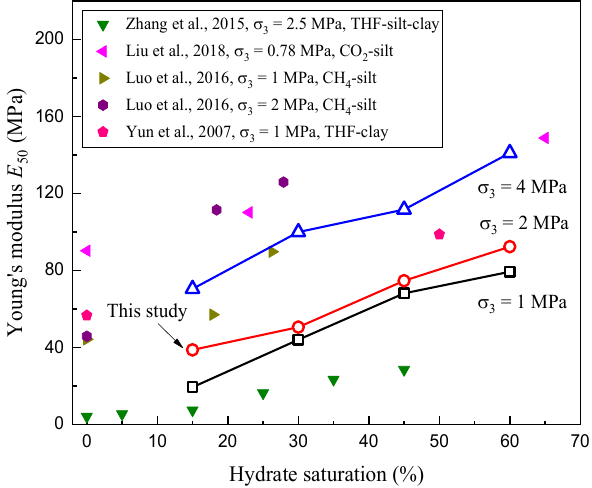
Figure 5. Variation of Young’s modulus E 50 with hydrate saturation (based on [21–23,27]).